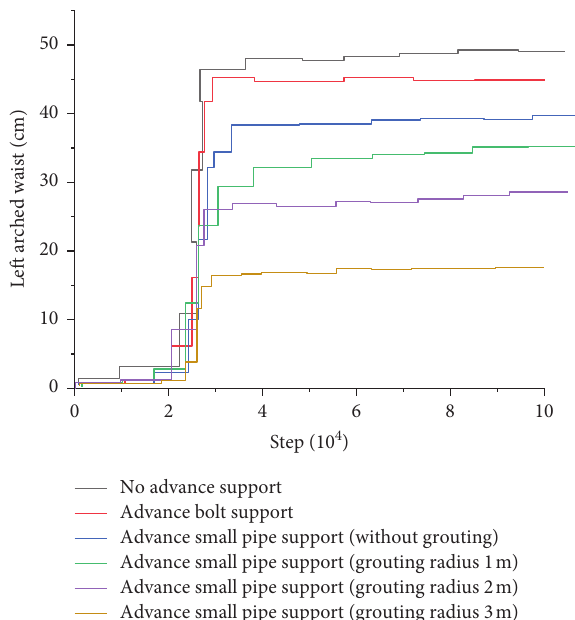
Figure 9: Convergence characteristics of left arch waist under different advanced support schemes.